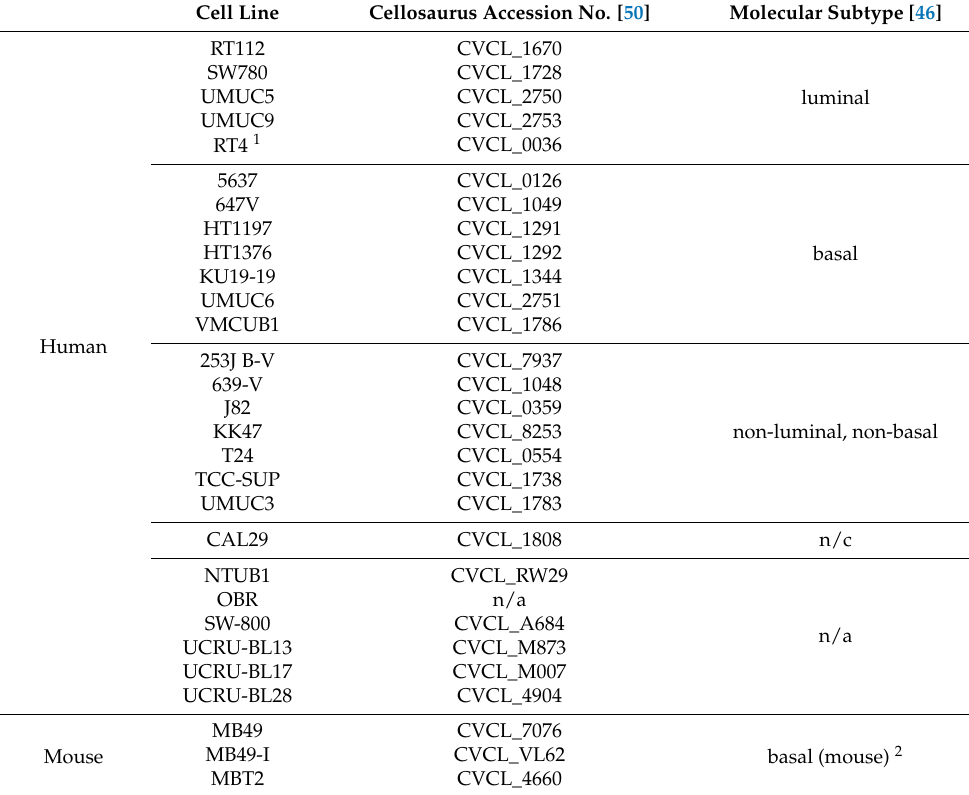
Table 1. BCa cell lines used in RT